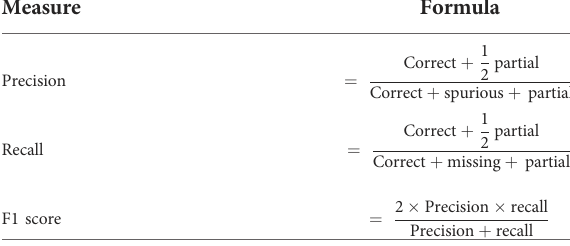
TABLE 1 Formulae used to calculate precision, recall, and F1